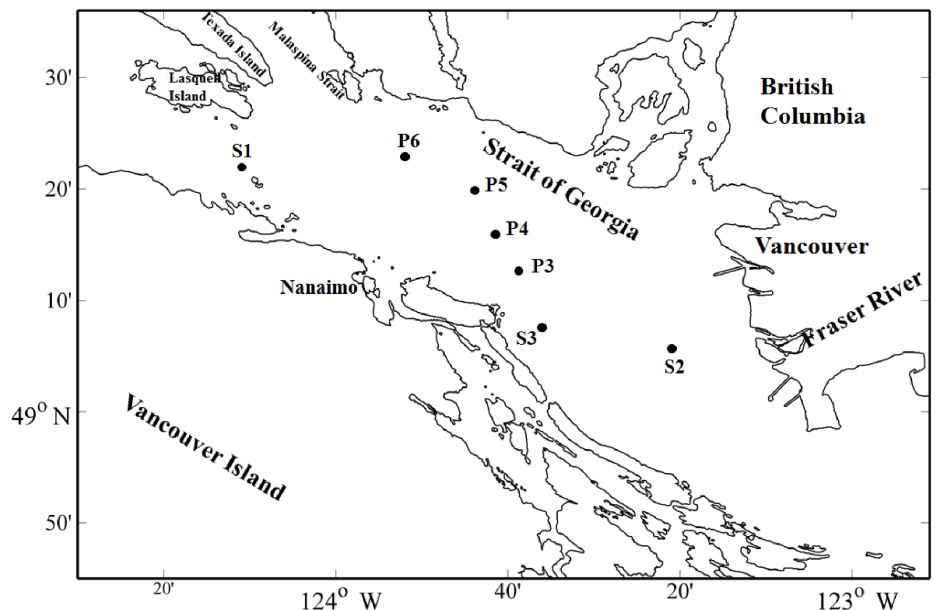
Figure 2. Map of the Strait of Georgia showing the study area and the sampling stations. Note that the Fraser River is located to the right, with two river channels flowing into the Strait of